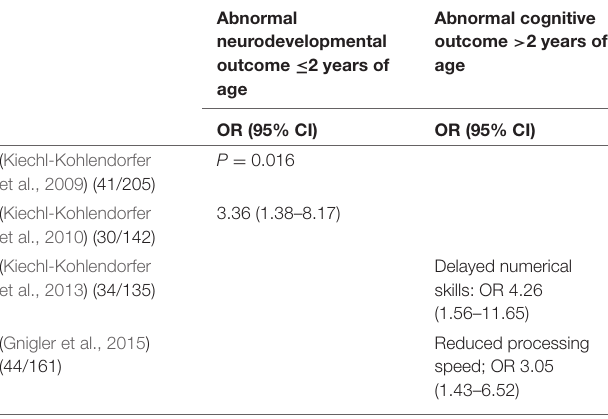
TABLE 3 | The outcomes of the four included articles about maternal smoking during pregnancy divided according the developmental outcomes (abnormal cognitive outcome ≤ / > 2 years of age or